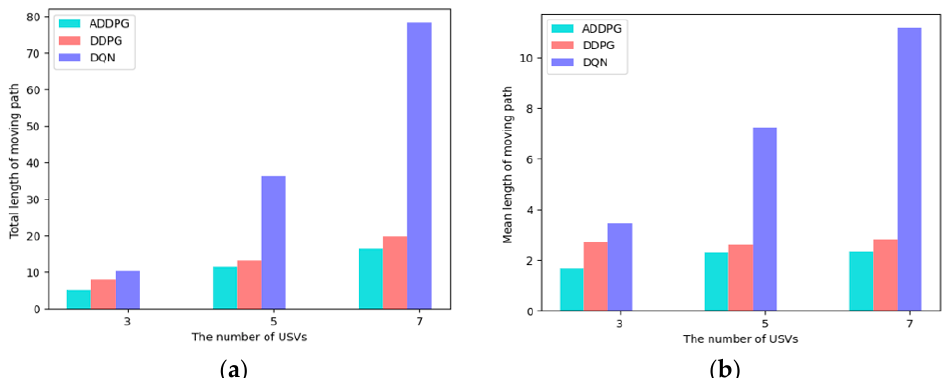
Figure 6. The total length and the average length of the moving path with the different number of multiple cooperative USVs and different schemes: ( a ) comparison of total moving length of the USV team with different team sizes; ( b ) comparison of the total average length of the USV team with different team sizes.